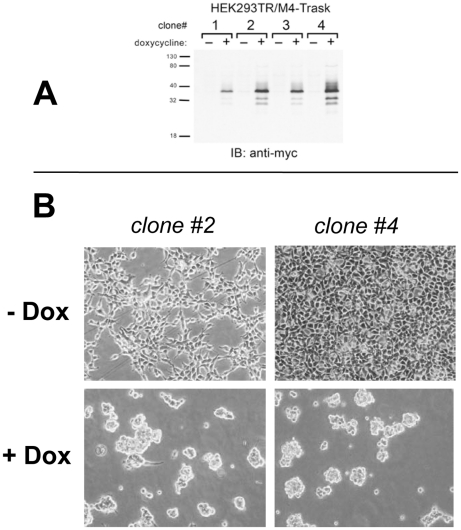
Effects of Trask phosphorylation in HEK293 cells.
A) HEK293TR cells were engineered to express the M4-Trask mutant in a tet-inducible fashion. The doxycycline inducible expression of M4-Trask is shown here for four different clones. This blot is representative of two independent experiments. B) HEK293TR/M4-Trask cells were plated in the presence or absence of 1 ug/ml doxycycline and the following day observed under phase contrast microscopy. Although not obvious in these still photographs, many of the cell clumps in the doxycycline treated arm are loosely adhered or entirely in suspension. This experiment has been performed 4 times with similar results.